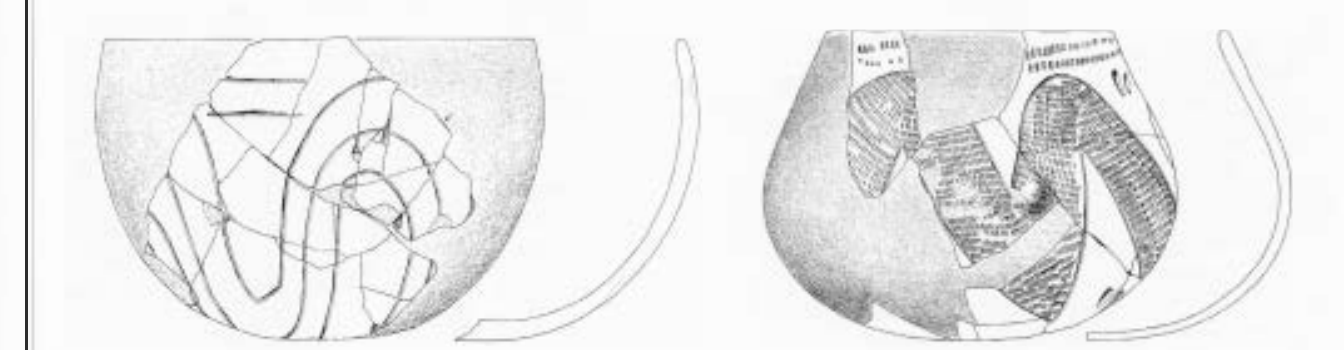
Figure 2 Examples of early (left) and late (right) Neolithic Linear Pottery (Bandkeramic) vessels from the Merzbach